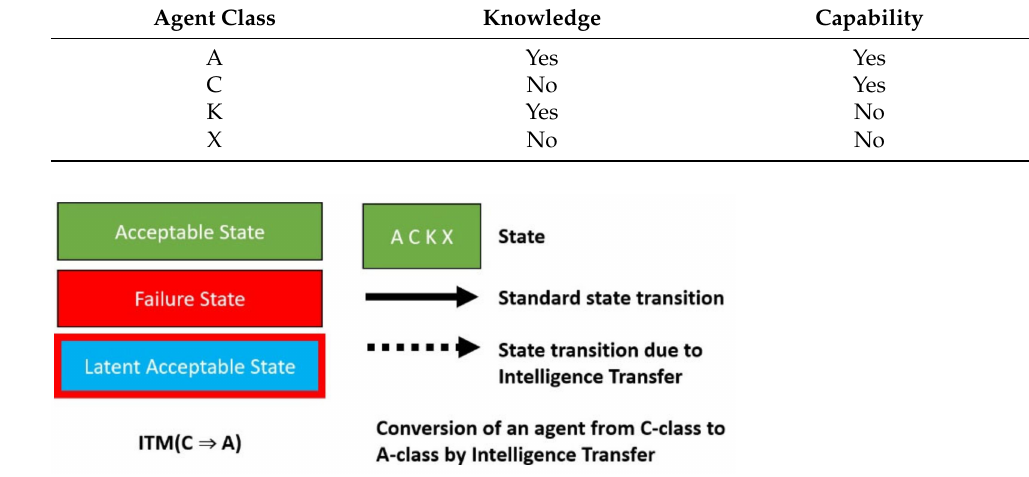
Figure 12. Legend for Static and Dynamic TBRM state